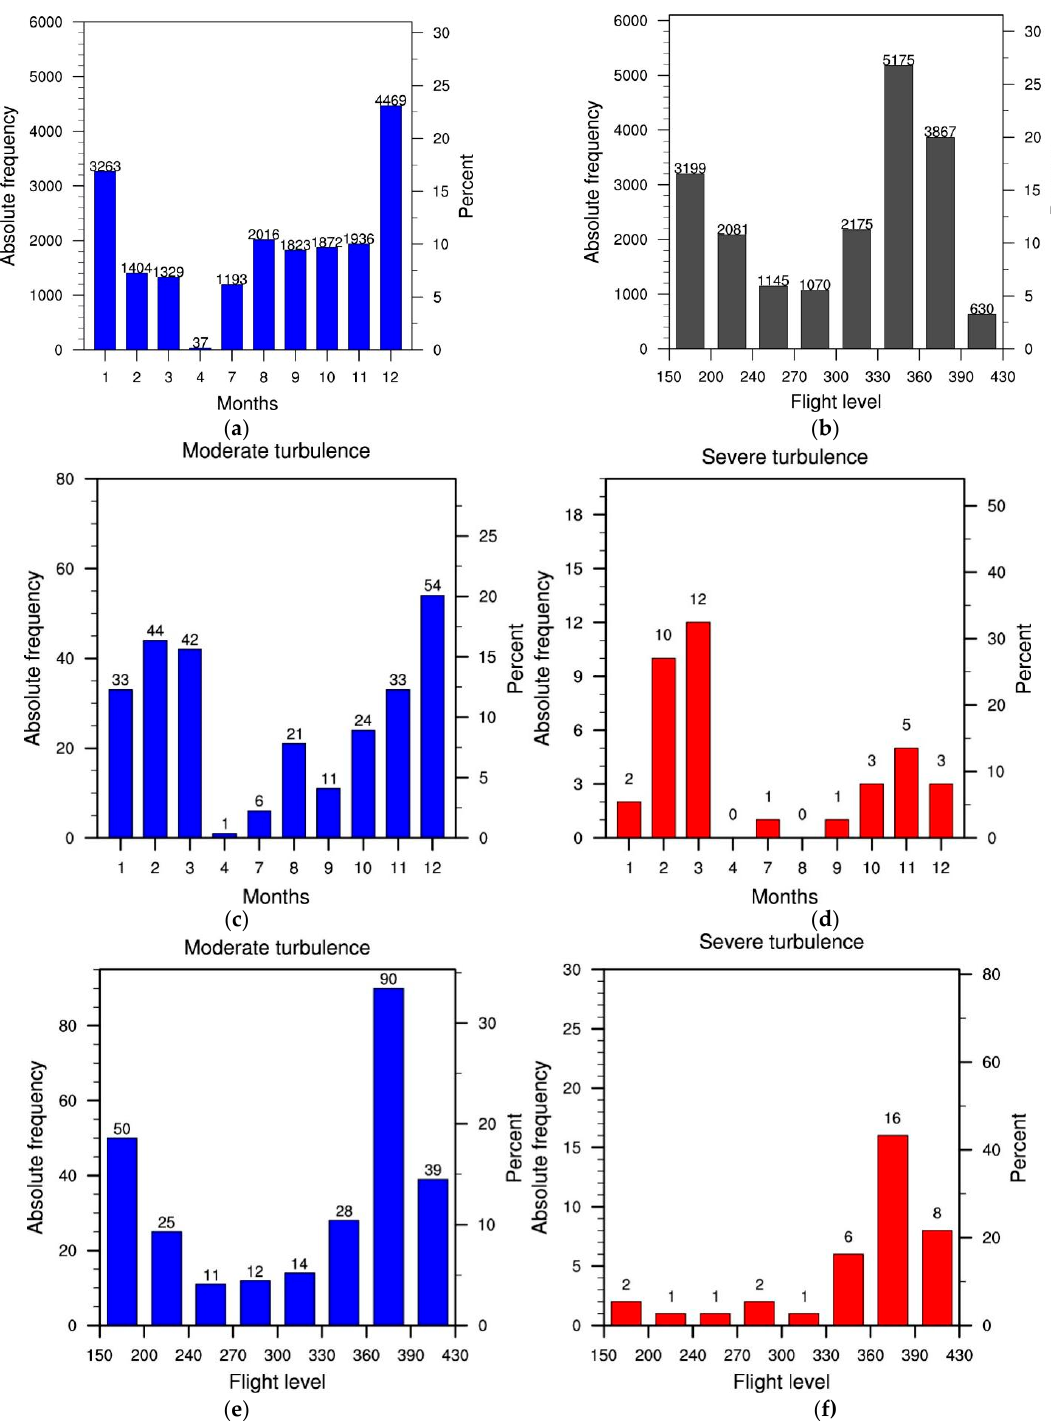
Figure 3. Distribution of turbulence observations by ( a ) months and ( b ) altitude. Distribution of moderate turbulence encounters by ( c ) months and ( e ) altitude. Distribution of severe turbulence encounters by ( d ) months and ( f ) altitude. The number of reports is also included in each figure.